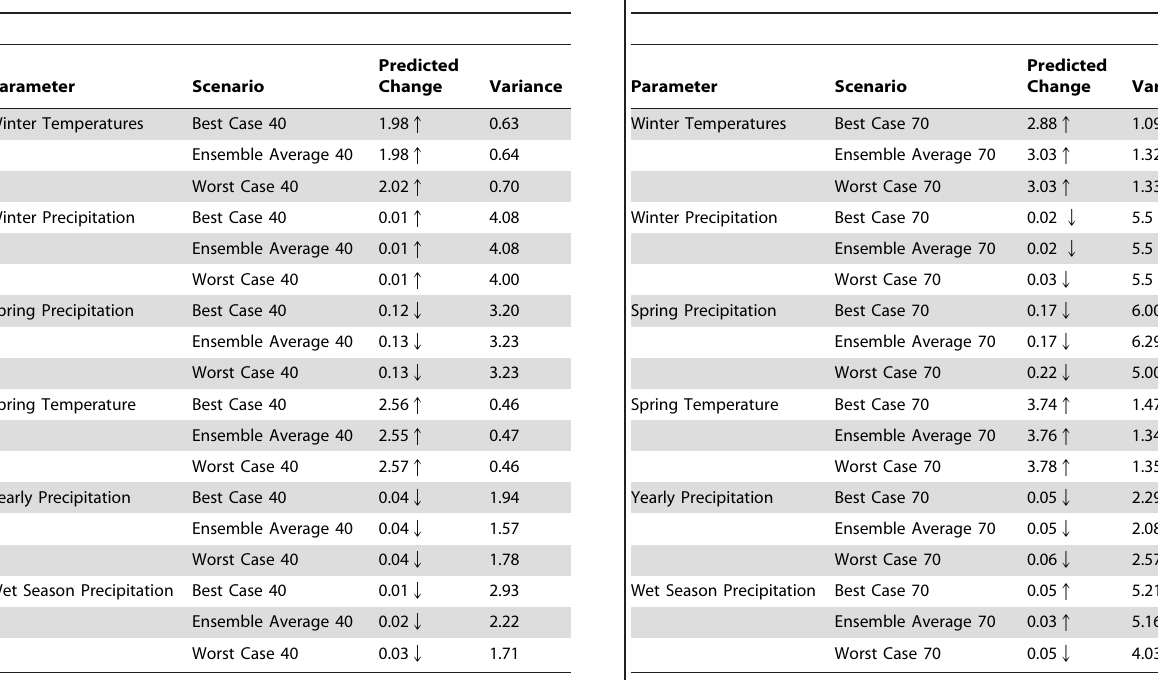
Table 2. Mean predicted change for temperature ( u C) and precipitation (cm) from 3 climatic forecasts used to predict mean clutch size, incubation initiation, and daily survival rates for lesser prairie-chicken populations in 2050.